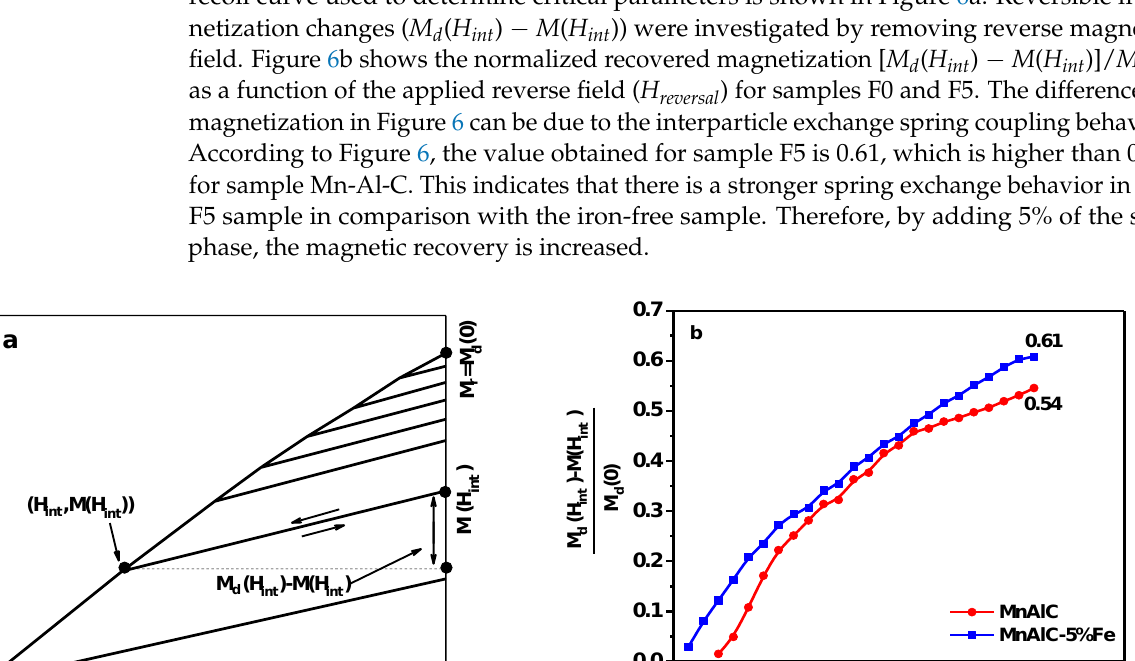
Figure 5. ( a – e ) Recoil demagnetization curves, ( f – n ) magnetization curves M(H) and dc demagnet- ization remanence M d (H) vs applied reversal field.